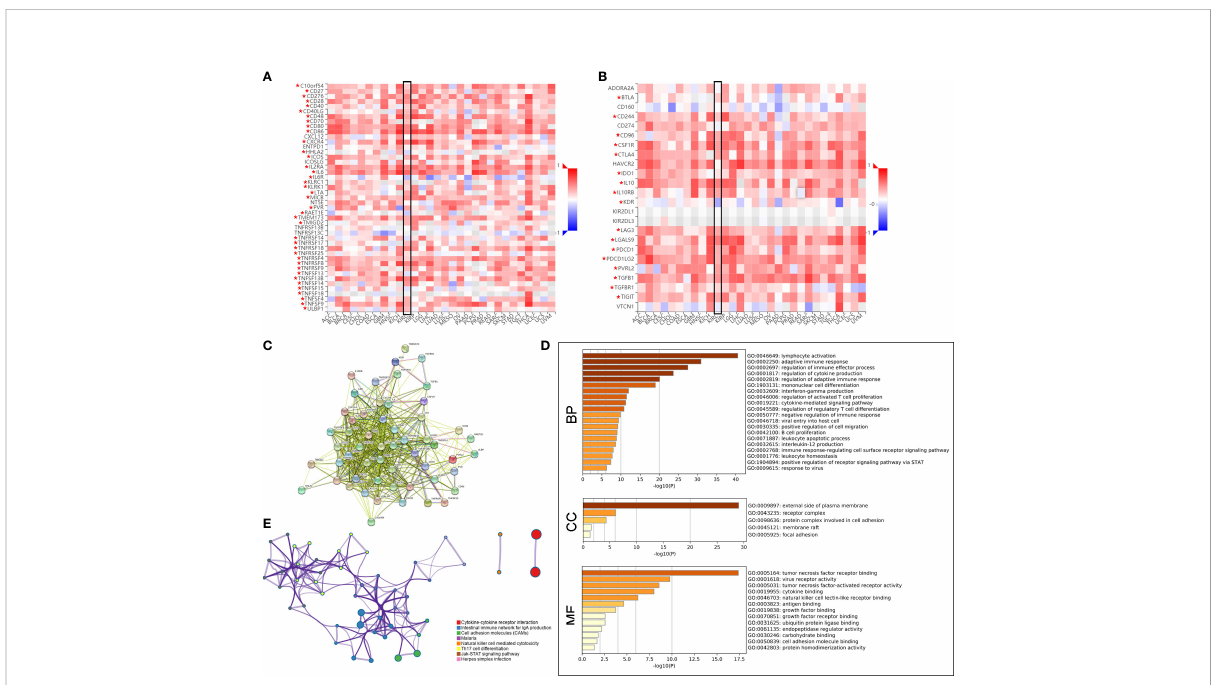
FIGURE 7 Identi fi cation of PLAUR-related immunomodulators (PRIs). (A – B) The correlation heatmaps of PLAUR with immunopotentiators (A) and immunosuppressants (B) . (C) Protein – protein network of 55 PRIs. (D) Gene Ontology annotation of 55 PRIs. (E) Kyoto Encyclopedia of Genes and Genomes pathway analysis of 55 PRIs. * P value<